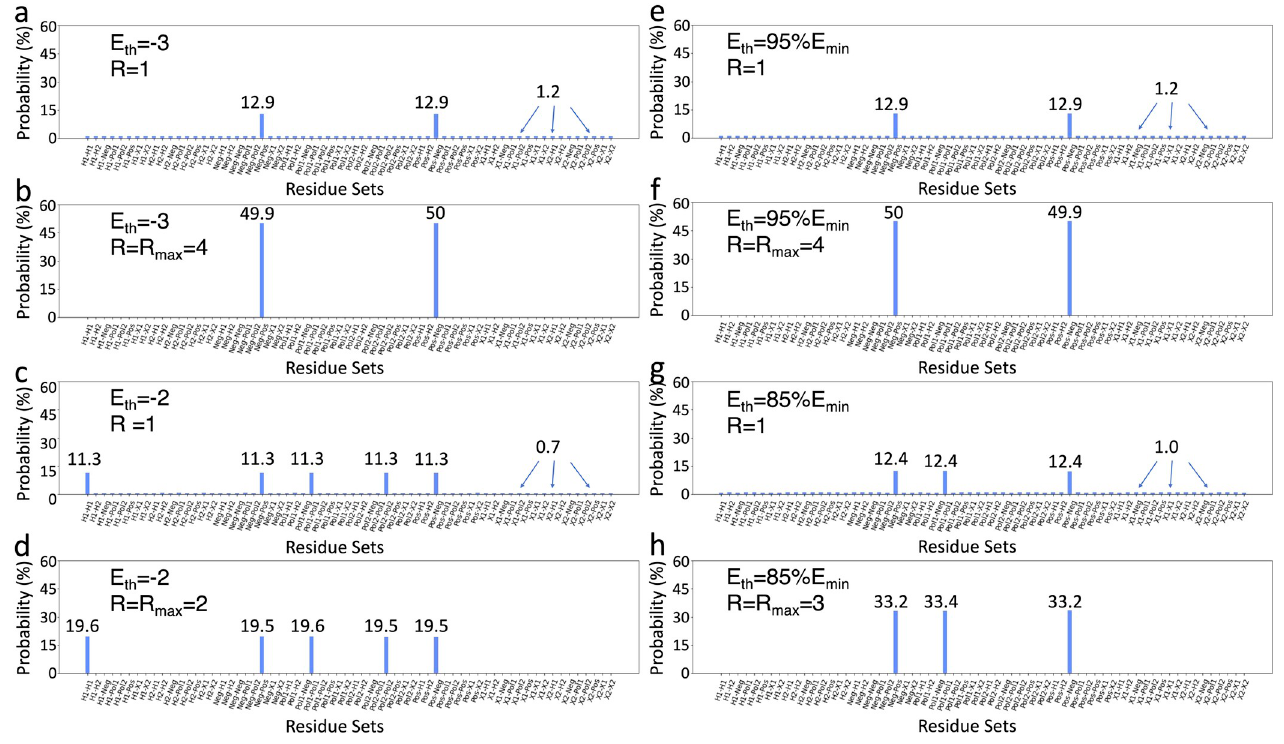
Fig 4. Histogram representations of the probability of finding each state (64 in total) in circuits with two designable sites. Results for circuits in the SP model with: a) E th = -3 and R = 1; b) E th = -3 and R = R max = 4; c) E th = -2 and R = 1; d) E th = -2 and R = R max = 2. Results for circuits in the MR model with: e) E th = 95%Emin and R = 1; f) E th = 95%E min and R = R max = 4; g) E th = 85%E min and R = 1; h) E th = 85%E min and R = R max = 3.